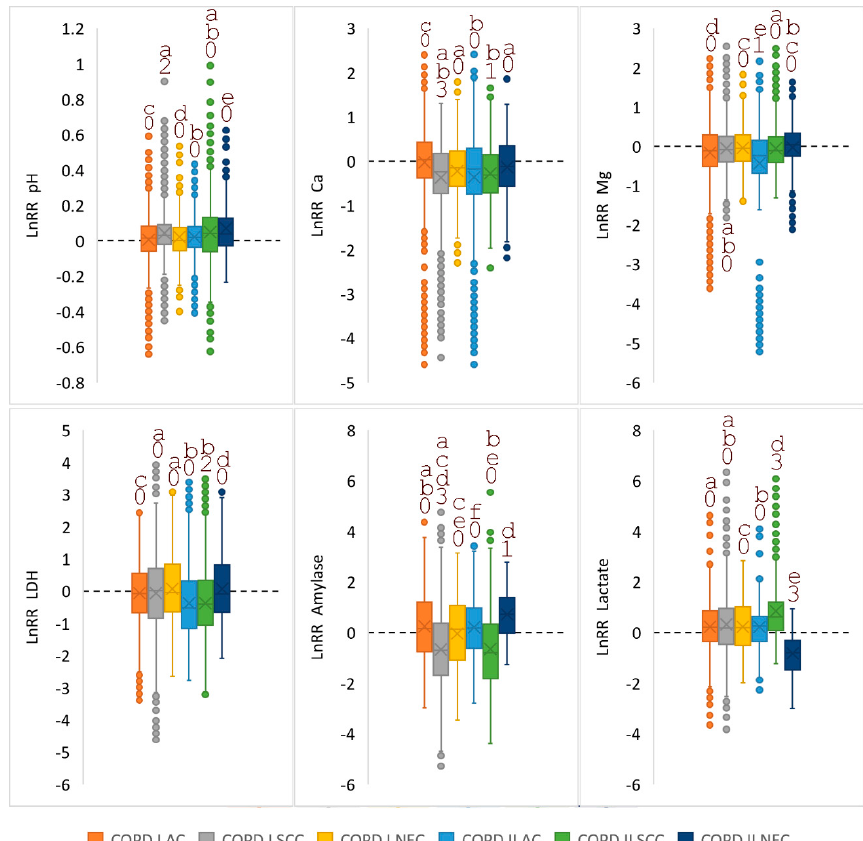
Figure 2. The intensity of the difference (LnRR = Ln (COPD/NO COPD)) in saliva biochemical parameters for different histological types of lung cancer, depending on the presence/absence of COPD. The rectangles show the mean (line) and median (cross); individual points show values outside the interquartile range. The same letters (a, b, c, d, e, f) denote groups, the di ff erences between which were not revealed ( α = 0.05). The dotted line represents the zero level (LnRR = 0). Significance of di ff erence from 0 was checked using the t-test of one sample and indicated by numbers (“0”: not significant; “1”: p < 0.05; “2”: p < 0.01; “3”: p < 0.001). AC—adenocarcinoma; SCC—squamous cell carcinoma; NEC—neuroendocrine lung